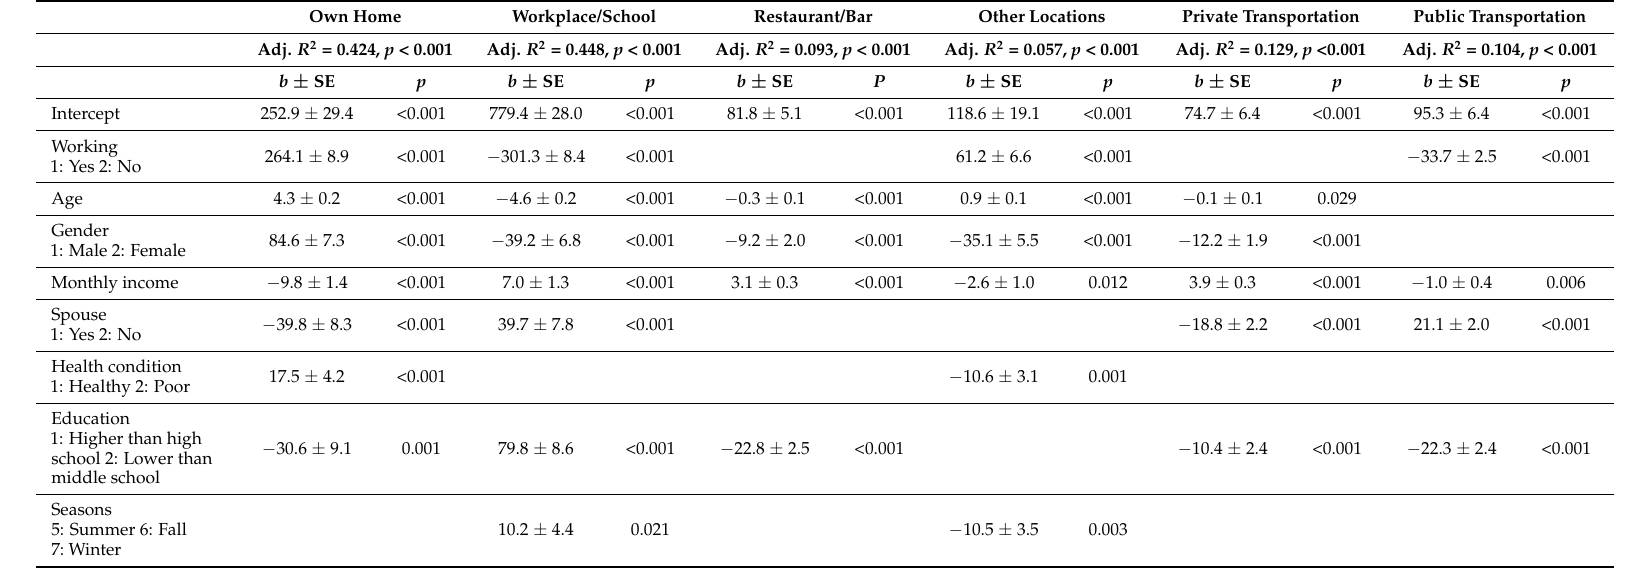
Table 4. The factors that influence the time spent at six locations in